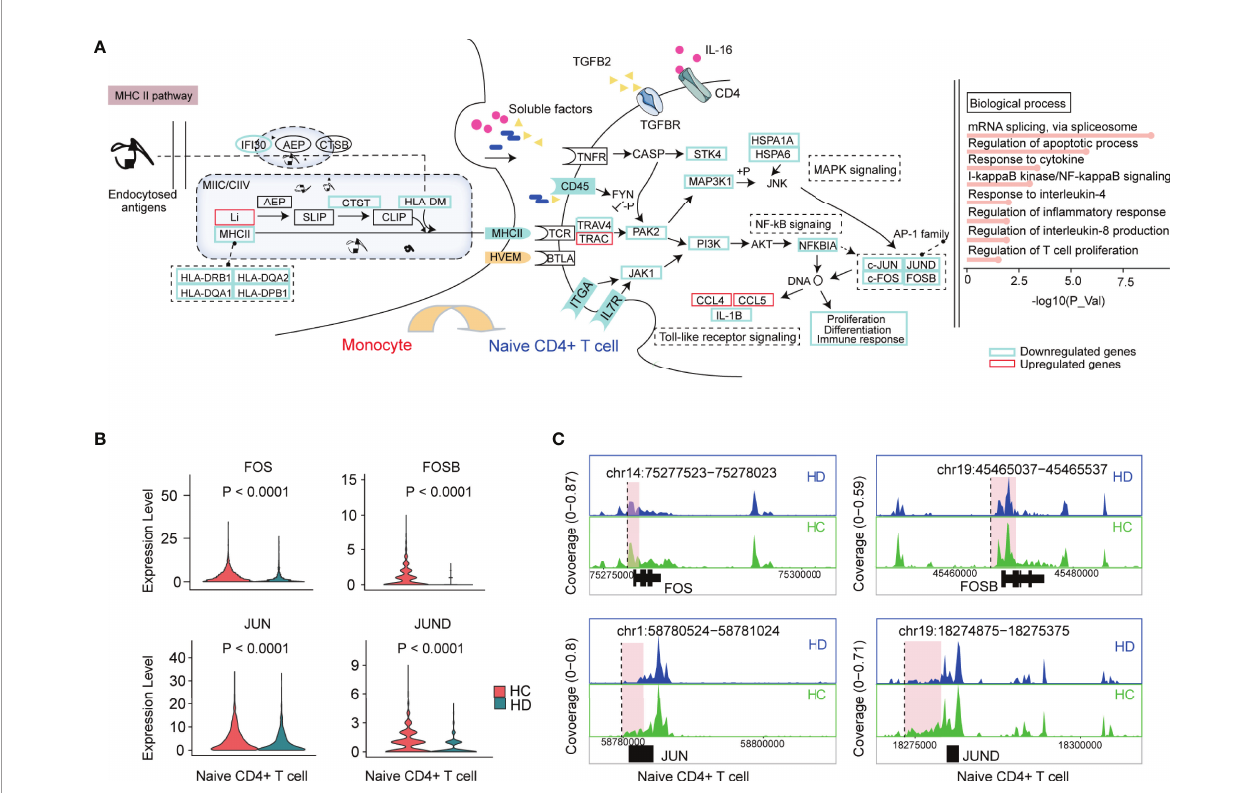
FIGURE 5 | The characteristic of the transcriptional regulation of naive CD4+ T cells in HD patients. (A) The schematic illustration of cellular communication between monocytes and naive CD4+ T cells in HD patients. In brief, dysfunctional TCR-pMHCII, TGFB, CD40, and BTLA signalings lead to changes in TCR downstream pathways and biological processes. Genes signi fi cantly downregulated and upregulated in naive CD4+ T cells from HD patients are marked with blue and red boxes, respectively. (B) Violin plots showing the differential expression of AP-1 family TFs ( FOS , FOSB , JUN , JUND ) in naive CD4+ T cells between HD and HC groups. (C) Mean scATAC-seq coverage at FOS , FOSB , JUN , JUND locus in naive CD4+ T cells. Differential peaks are marked with red boxes. TCR, T cell receptor; MHCII, major histocompatibility complex II. AP-1, activator protein 1; TFs, transcription